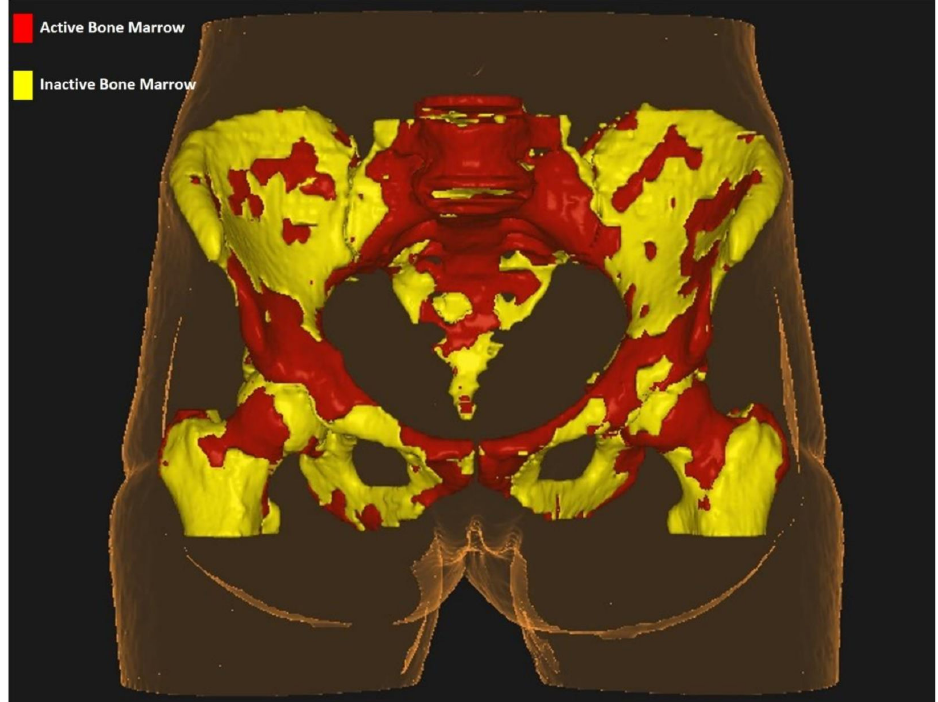
Figure 1. Active bone marrow segmentation within the